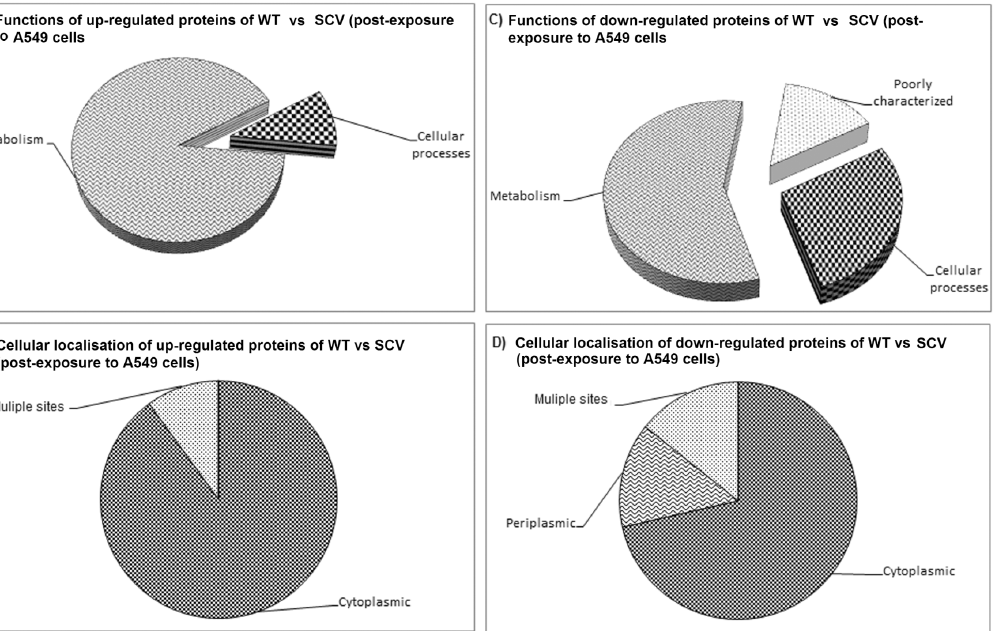
Fig 5. Protein categories and the subcellular localisation of Burkholderia pseudomallei WT vs SCV (post-exposure to A549 cells). Functional protein categories were predicted using COG, while subcellular localisation was predicted using PSORT. Panels A and B refer to functions and cellular location of the up-regulated proteins, respectively. Panels C and D refer to functions and cellular location of the down-regulated proteins, respectively.